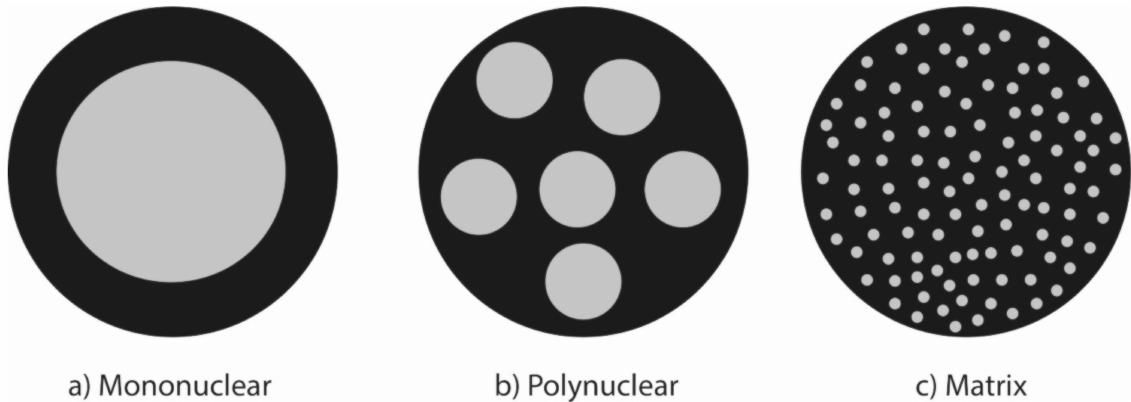
Figure 4. Structures resulting from a coating. ( a ) mononuclear: a single cluster of material within the capsule; ( b ) polynuclear: different large cluster of material within the capsule; ( c ) matrix: small centers or dispersed material within the